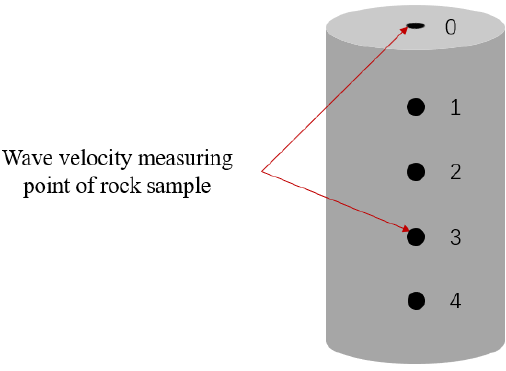
Figure 1. Wave velocity measuring points of rock samples.